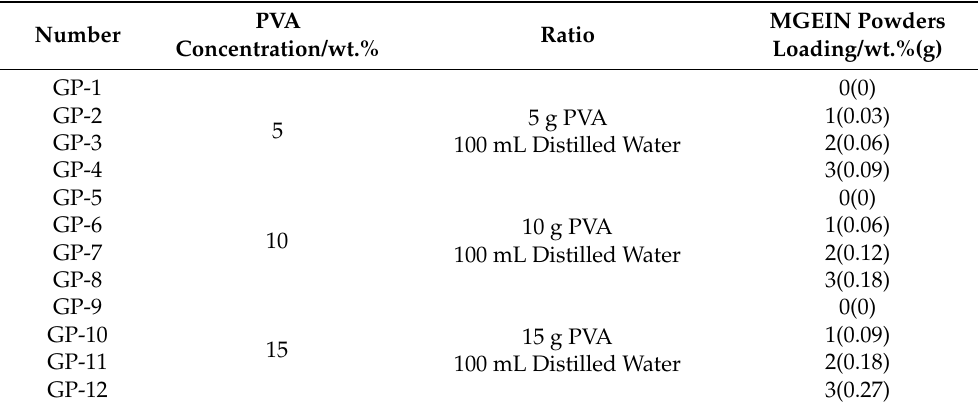
Table 1. The formulations of Gr/PVA impregnation